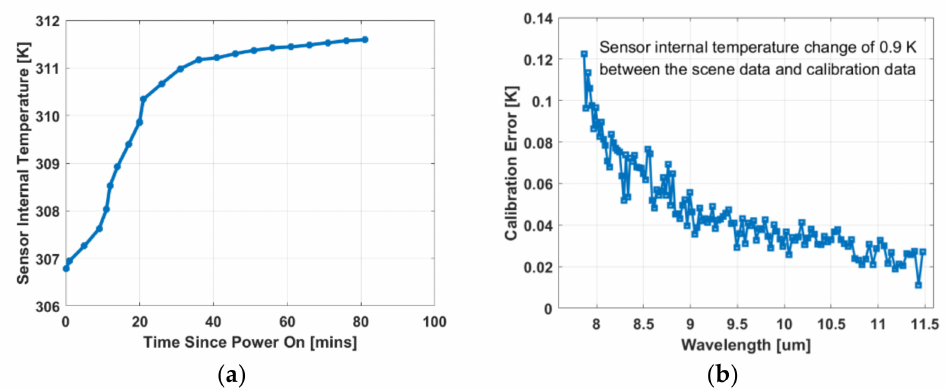
Figure 4. Instrument calibration performance test: ( a ) sensor internal temperature change with time; ( b ) the calibration error in brightness temperature units when the TD equaled 0.9 K.